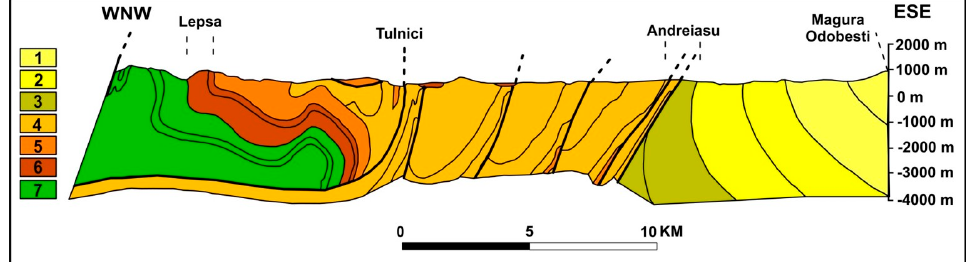
Figure 8. Cross-section at the limit between the Eastern Carpathian flysch units and the Foredeep, showing the structural style for Lepsa and Andreiasu seeps. 1: Upper Pliocene (sands, sandstones, clays); 2: Lower Pliocene (sands, sandstones, clays); 3: Upper Miocene (marls, sandstones, volcanic tuffs); 4: Lower Miocene (sandstones, marls, evaporites); 5: Oligocene (menilites, dysodiles, sandstones); 6: Paleocene-Eocene (sandstones, clays, marls); 7: Cretaceous (conglomerates, marls, limestones) (modified after